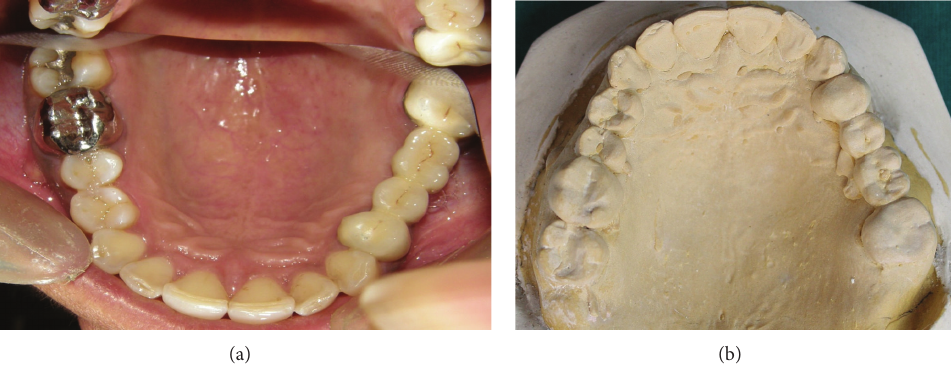
Figure 2: (a) Mirror image photograph showing 14 with mesiolingual and distolingual cusp. (b) Photograph of maxillary cast showing 14 with typical “Y” shaped occlusal groove, 3 cusps and a prominent lingual groove.